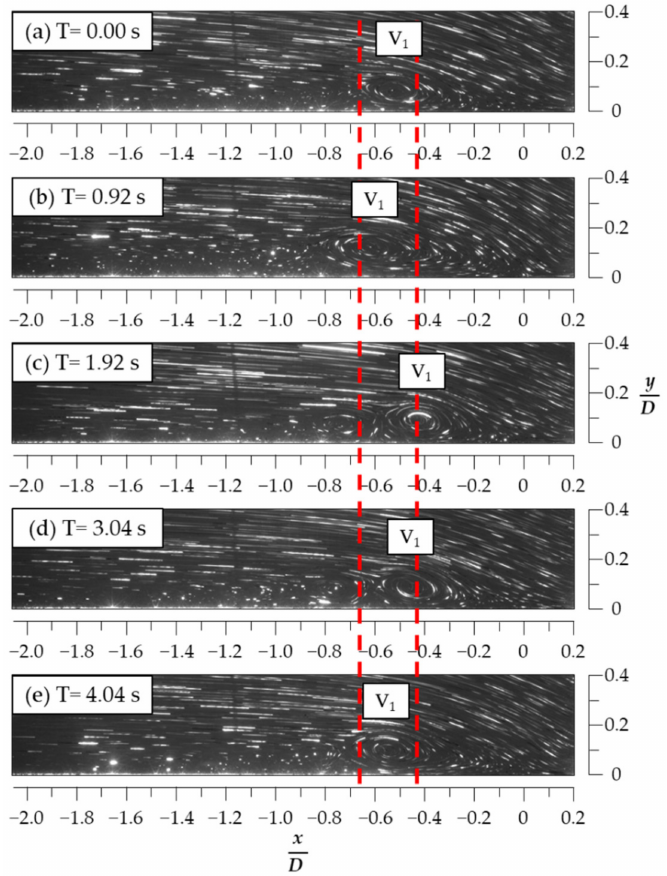
Figure 5. Time-series flow visualization of the HSV’s kinematic mode: “oscillation with a small displacement” in the z = 0.4 cm plane when H / D = 0. The two red dashed lines indicate the oscillation range of the core of the HSV closest to the LE (labeled V 1 ) between x / D = − 0.43 and − 0.64.